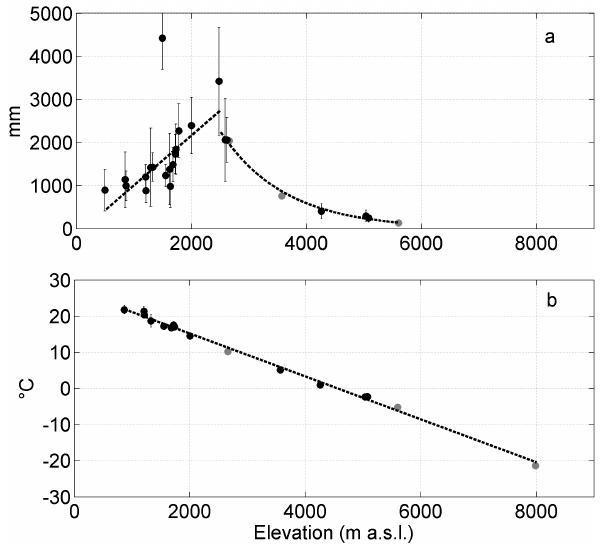
Figure 5. Lapse rates of (a) total annual precipitation in the Koshi Basin for the last 10 years (2003–2012) and (b) mean annual air temperature. The daily missing data threshold is set to 10%. Only stations presenting at least 5 years of data (black points) are consid- ered to create the regressions (the bars represent 2 standard devia- tions). Grey points indicate the stations presenting less than 5 years of